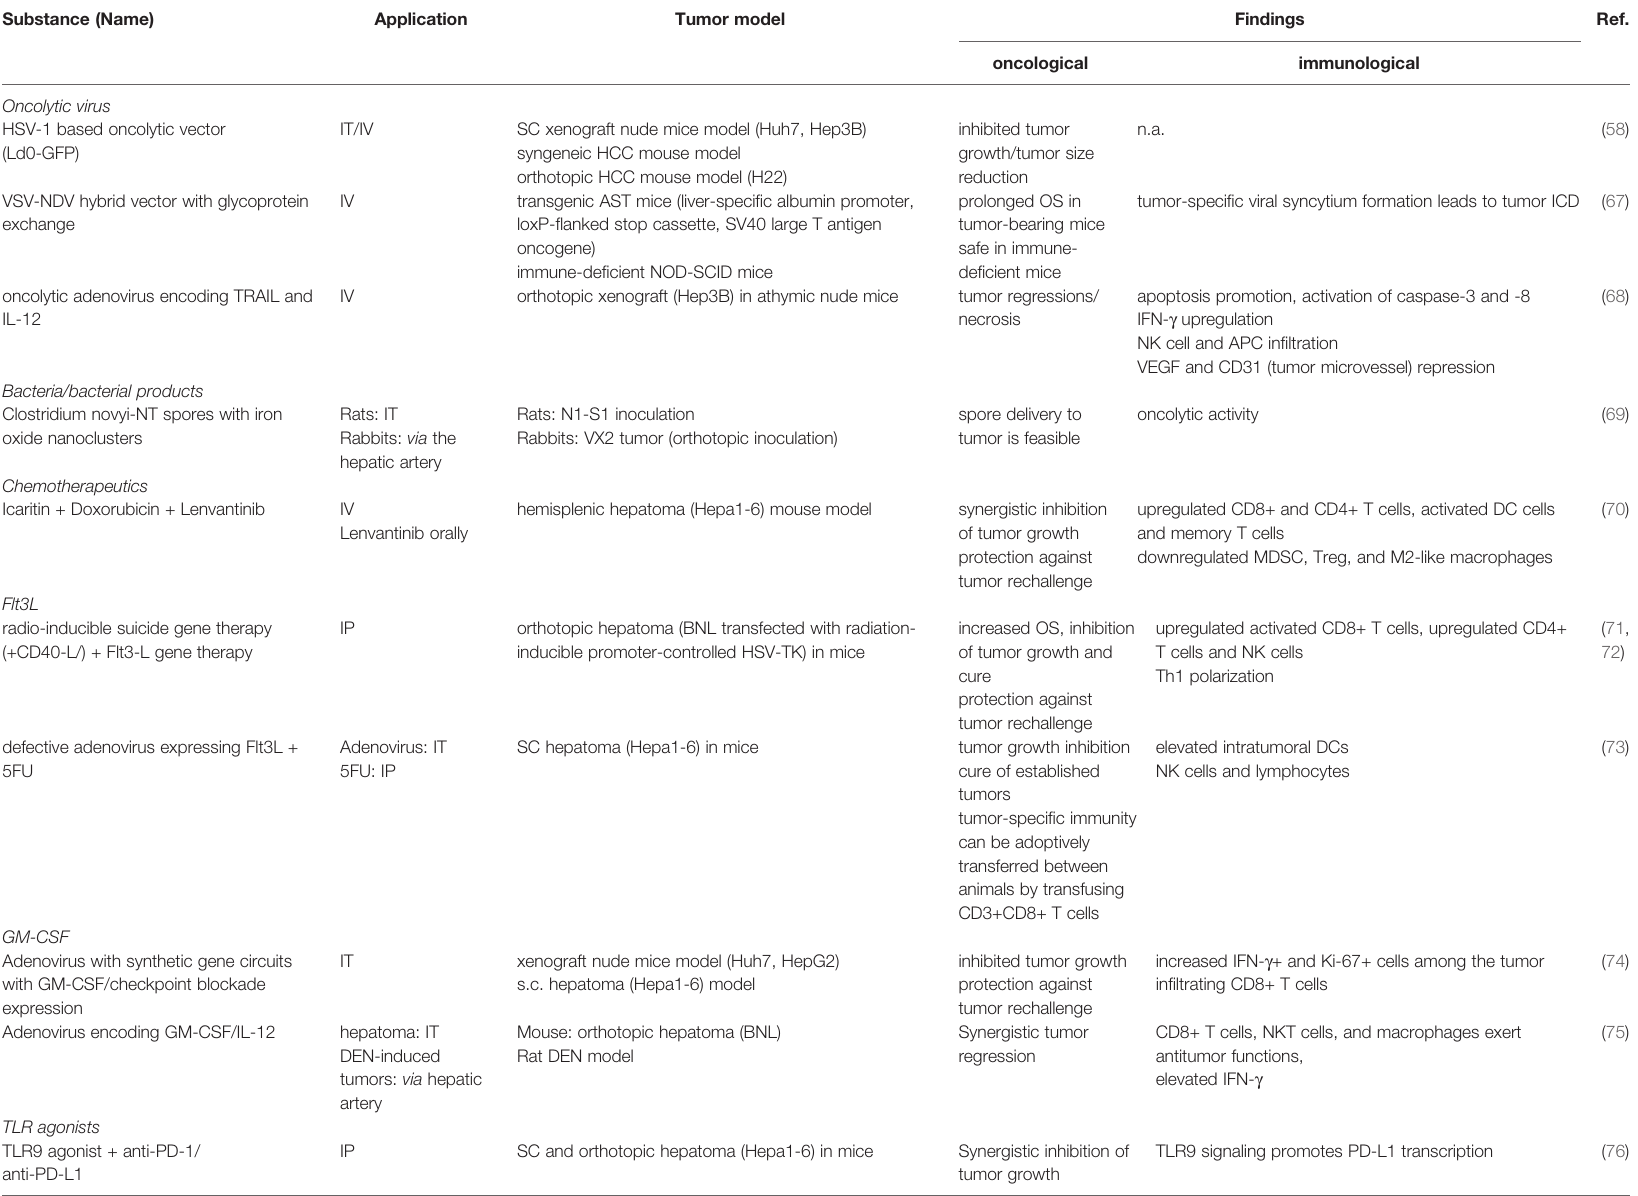
TABLE 2 | In vivo studies on in situ vaccines in